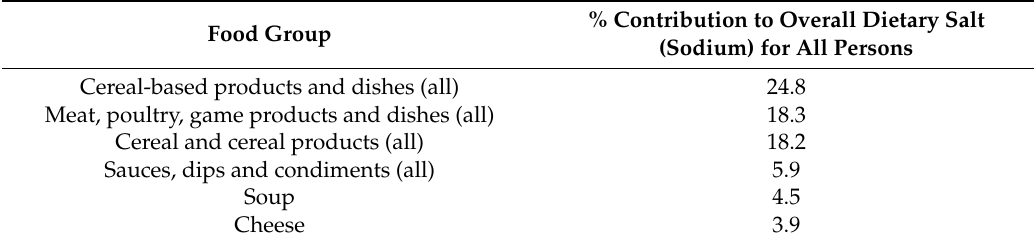
Table 1. Proportion of salt intake (%) from food groups using National Health Survey data 2014, adapted from [6]. Reproduced with permission from authors and